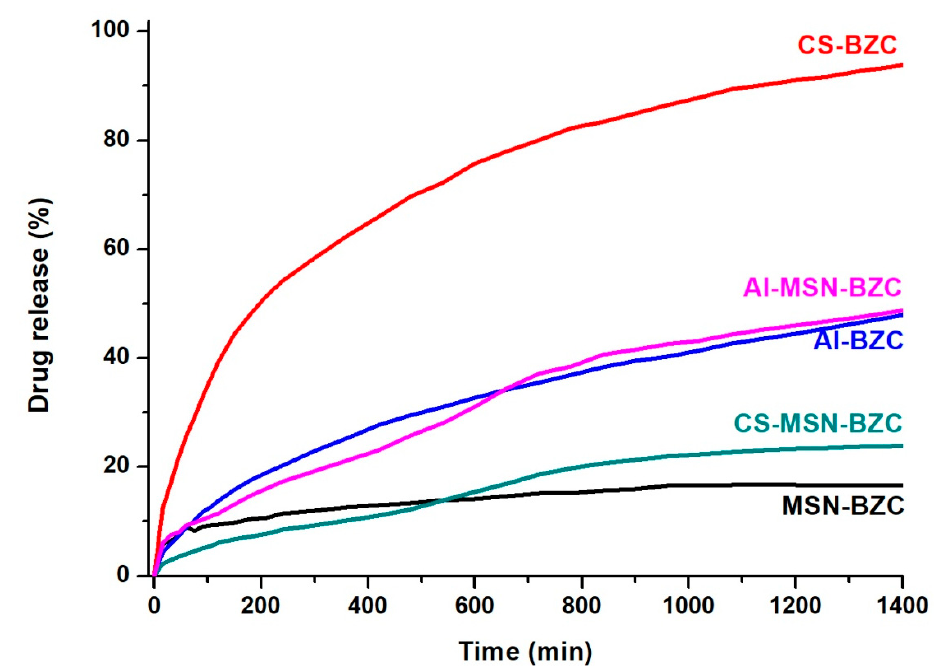
Figure 8. The release profile of BZC from different hybrid materials in simulated gastric fluid (SGF).